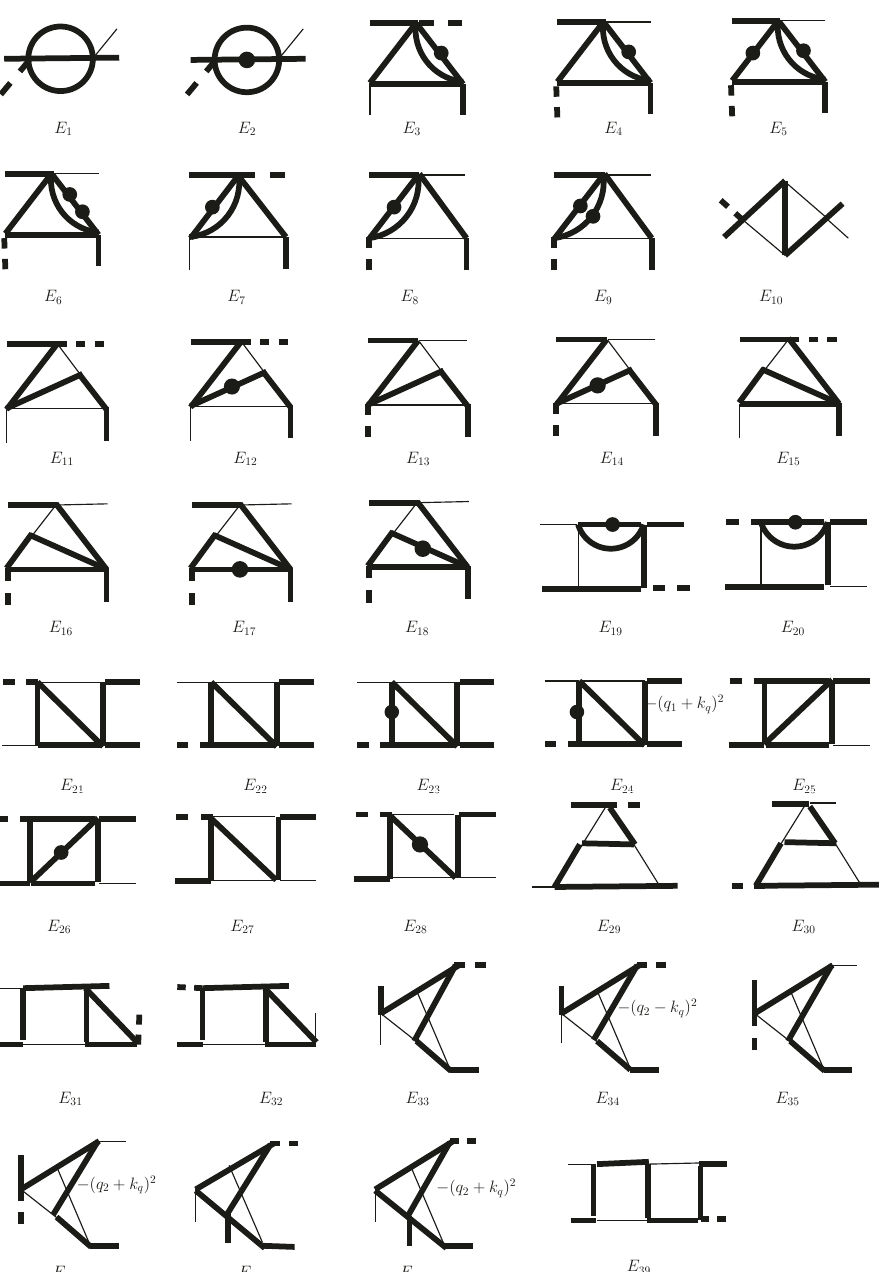
Figure 2 . The set of 39 master integrals involve elliptic functions in sector I. The thin line denotes massless propagators and on-shell massless external particles; the thick line represents massive propagators and on-shell massive external particles; the dash line indicates o(cid:11)-shell external particles with momentum squared equal to 2 ss . The internal lines with a dot mean the power of the propagators are raised to 2.